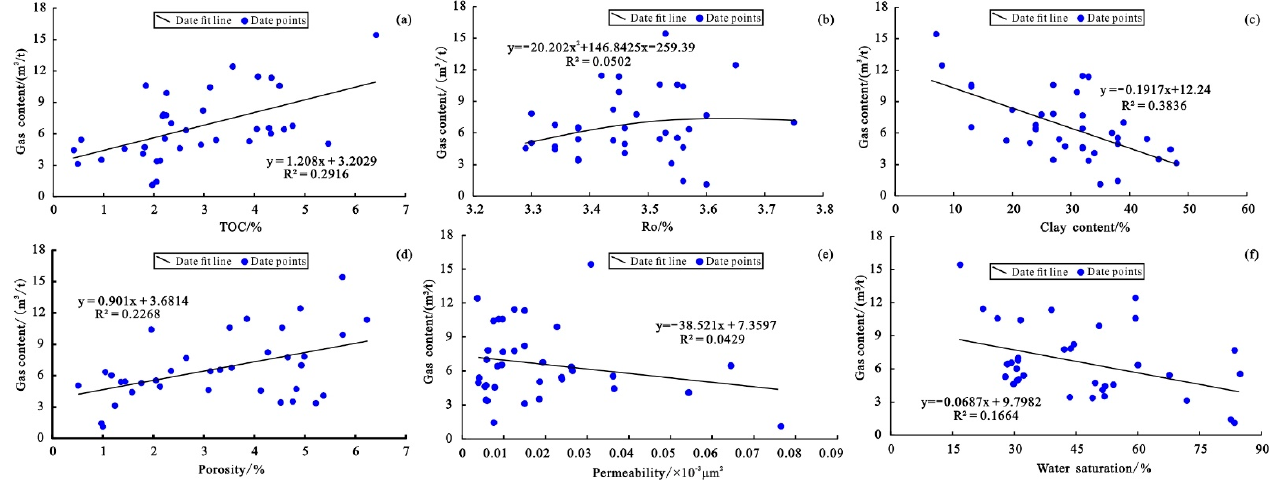
Figure 5. Relationship between shale development characteristics and gas content: ( a ) Relationship between TOC and gas content; ( b ) Relationship between Ro and gas content; ( c ) Relationship between TOC and clay content; ( d ) Relationship between porosity and gas content; ( e ) Relationship between permeability and gas content; ( f ) Relationship between water saturation and gas content.